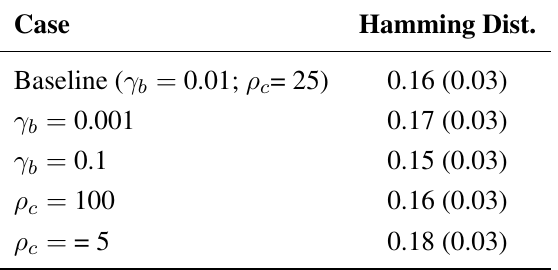
Table 2. Effects of misspecifying “Concentration Measure” parameters containing same information as in the previous